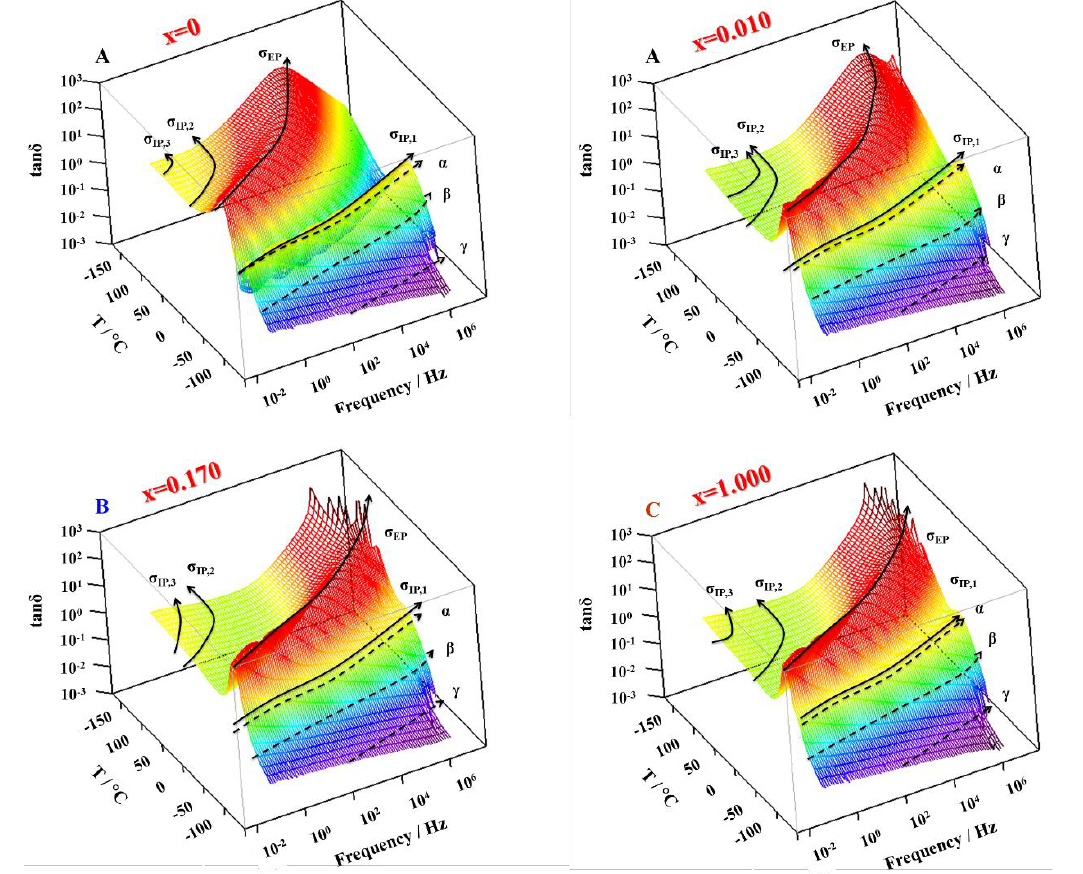
Figure 8. 3D tanδ surfaces of GlyLi x samples with x = 0, 0.010, 0.170, and 1.000. Figure 8. 3D tan δ surfaces of GlyLi x samples with x = 0, 0.010, 0.170, and